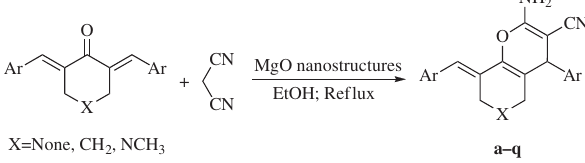
Scheme 2: Preparation of 4 H -pyran derivatives over MgO nanostructures.